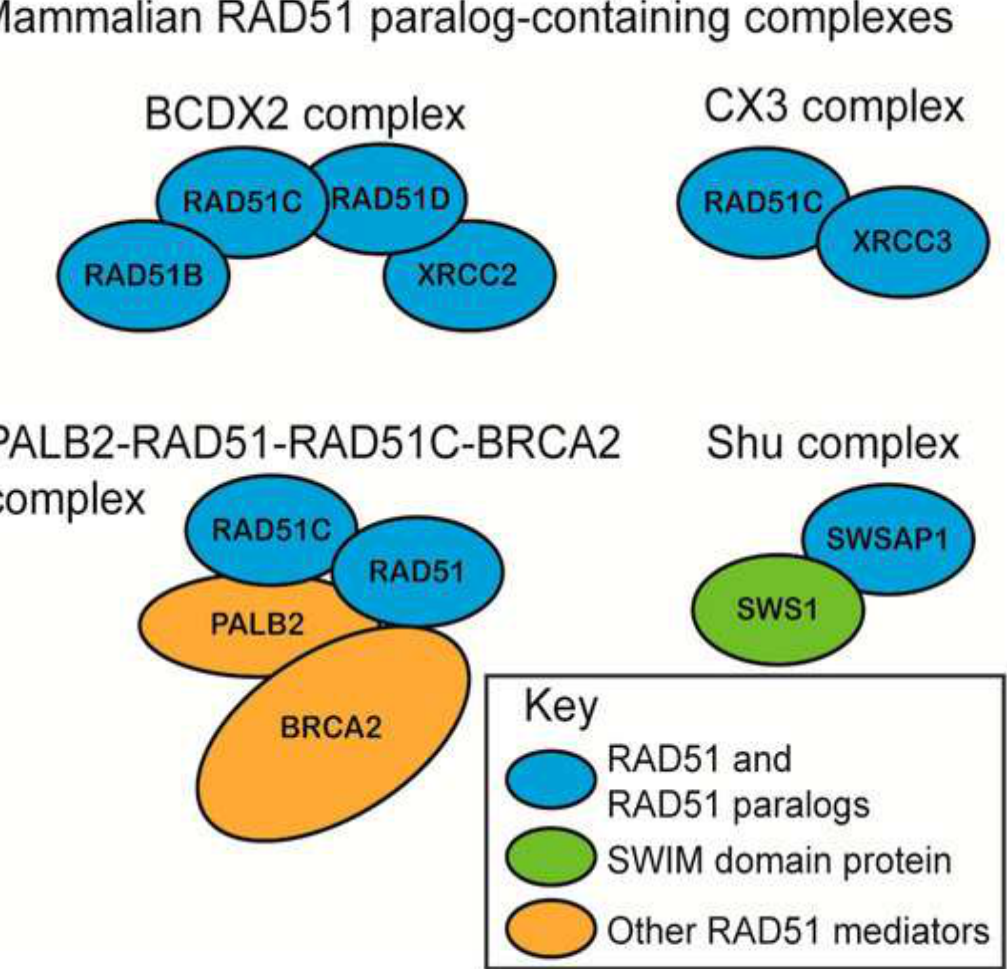
Figure 3. Schematic representation of the mammalian RAD51 paralog-containing complexes. While patients with biallelic mutations in RAD51 and its mediators have been iden- tified in patients with Fanconi anaemia, monoallelic germline mutations in RAD51 medi- ators are correlated to predisposition to cancer. This is thought to be frequently caused by a somatic loss of heterozygosity (LOH) event, where the second functional copy of the gene is deleted, resulting in genomic instability. Both RAD51C and RAD51D are EOC sus- mutation in BRCA1/2 genes. The prevalence of RAD51C loss-of-function germline PVs